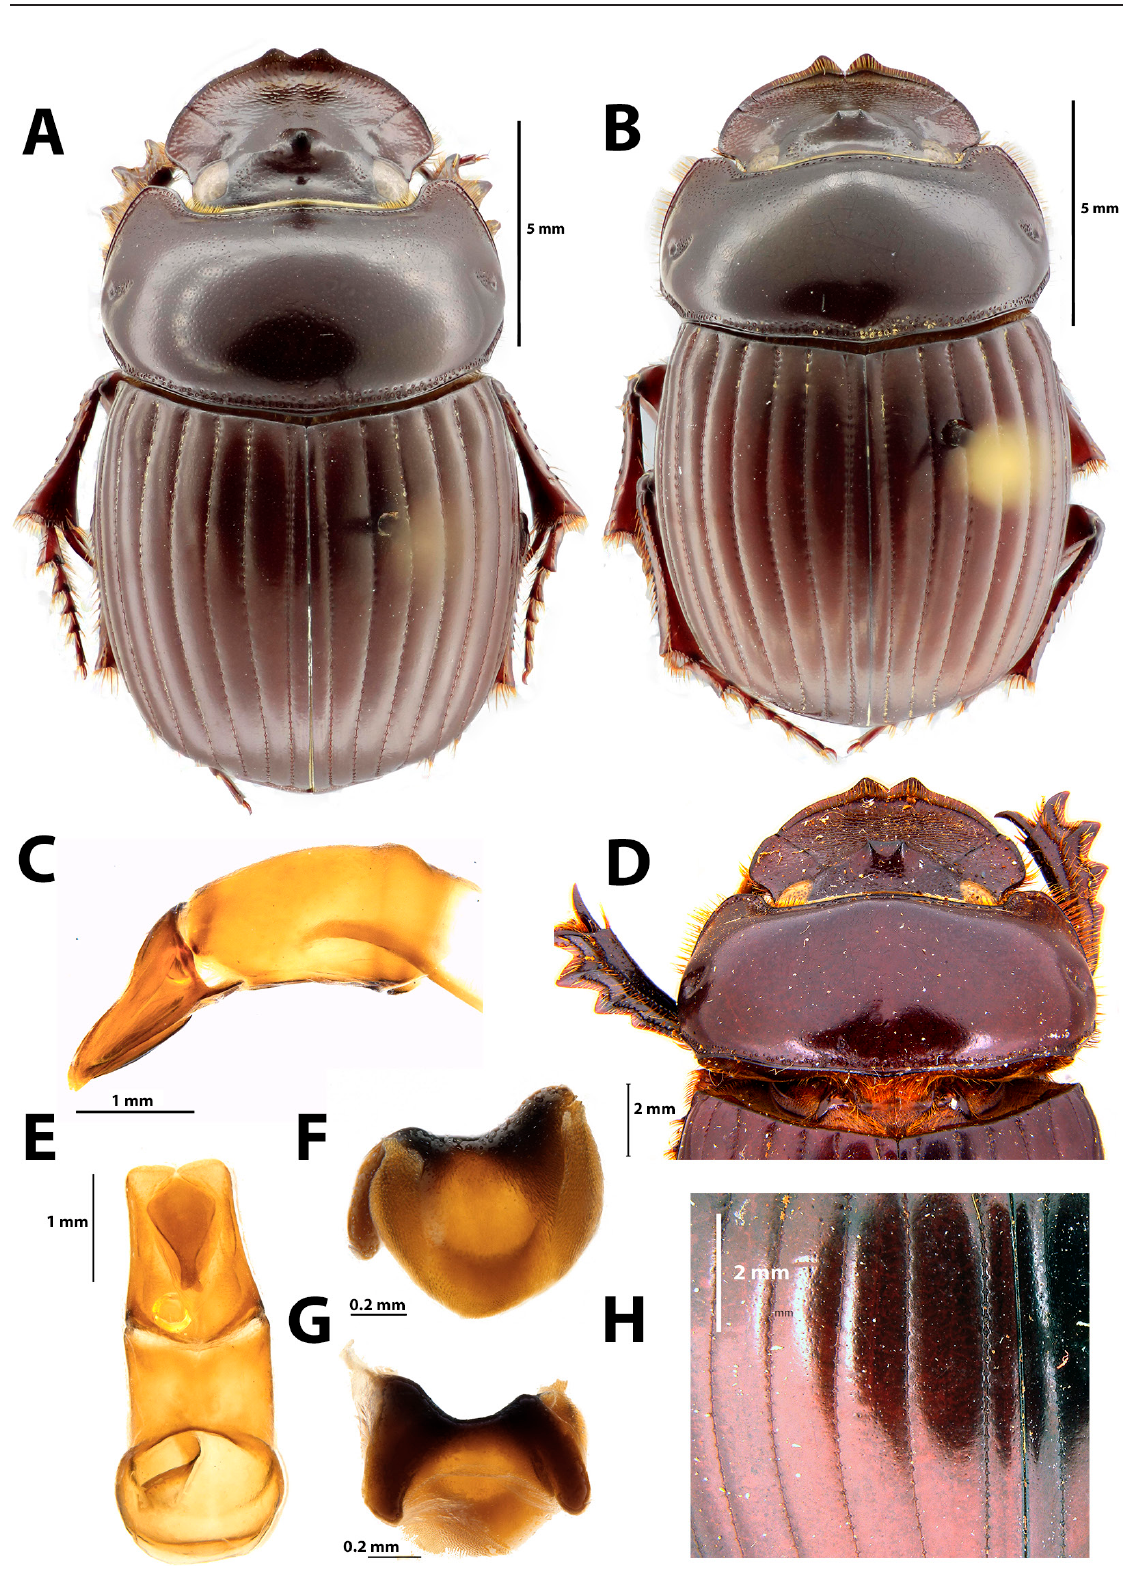
Fig. 16. Dichotomius triquetrus (Luederwaldt, 1923). A–B . Dorsal habitus. A . ♂. B . ♀. D . Lectotype, ♀ (MZSP). C . Lateral view of the aedeagus. D . Dorsal view of the head. E . Ventral view of the aedeagus. F–G . Lamella copulatrix. H .